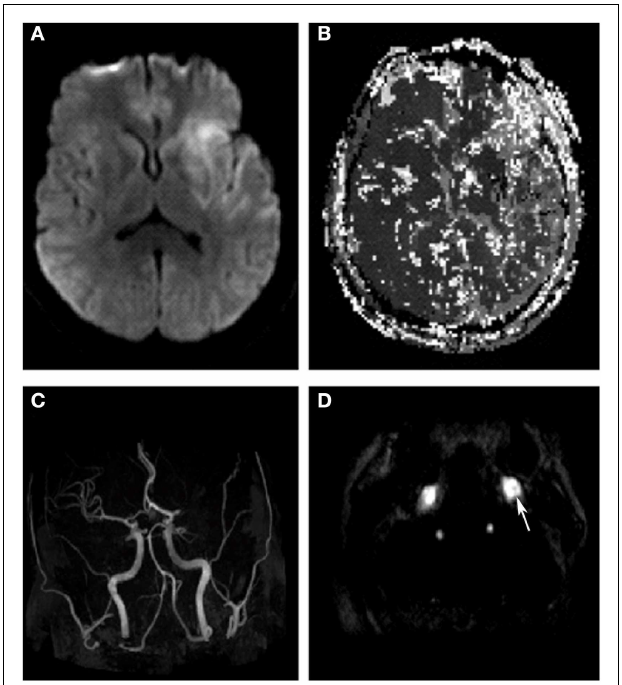
FIGURE 1 | Diffusion-weighted imaging shows left insular, frontal and superior temporal lobe early ischemic injury (A) . Perfusion-weighted imaging shows delayed time-to-peak in the entire left middle cerebral artery territory (B) .Time of flight, MRA head shows abrupt cutoff in the left M1 segment (C) , while contrast-enhanced axial MRA of the neck shows a hypointense mass partially occluding the lumen of the left ICA (arrow) (D) .